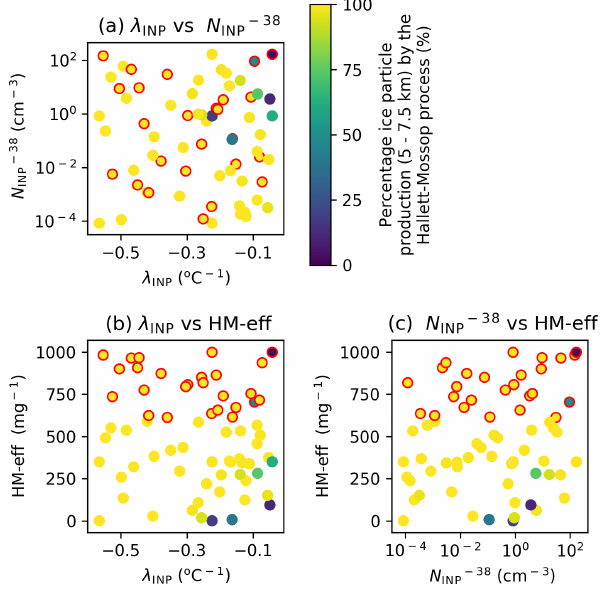
Figure A2. Source of ice crystals in the Hallett–Mossop region of the simulated deep convective cloud. Percentage of ice crystals pro- duced between 5 and 7.5km altitude that are produced from the Hallett–Mossop process [i.e. (Hallett–Mossop ice crystals/Hallett– Mossop and INP-produced ice crystals) × 100]. Simulations with a HM-eff above 600splintersmg − 1 are indicated with a red out- line. Ice particle production rates are calculated from the convective stage of the simulation (between 60 and